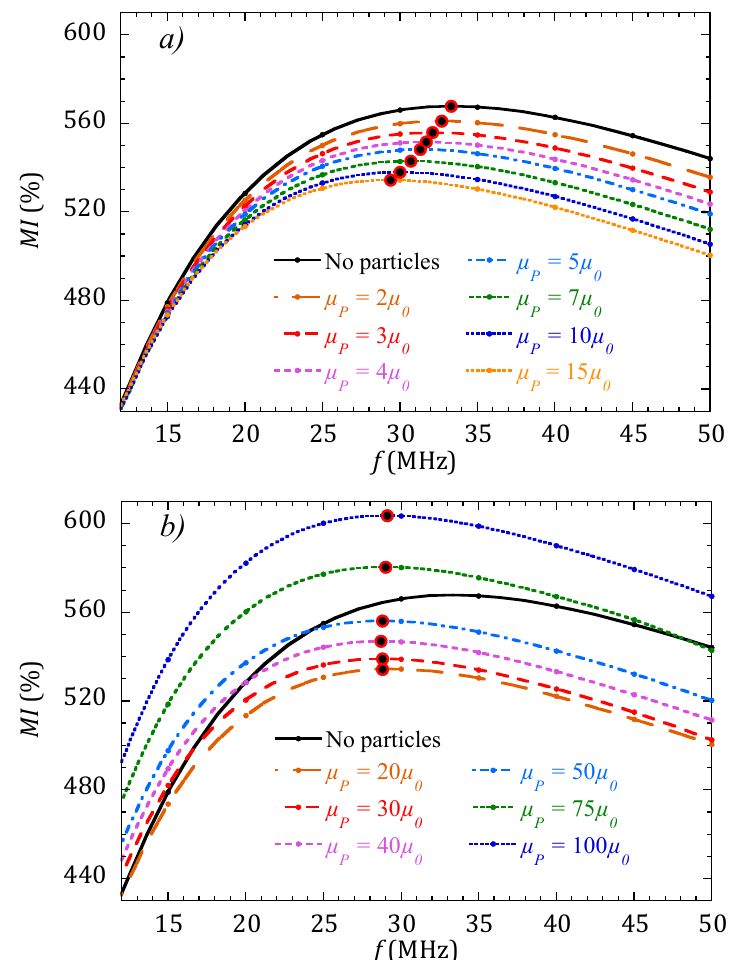
Figure 4. Variation of the MI curves calculated for a sensor with µ max = 5000 µ 0 when a drop with increasing MNPs concentration is placed on it. ( a ) for concentrations up to µ P = 15 µ 0 , the magnitude of MI decreases. ( b ) For larger concentrations, from µ P = 20 µ 0 , the magnitude of MI increases. Large red and black dots indicate the position of MI max for each curve.